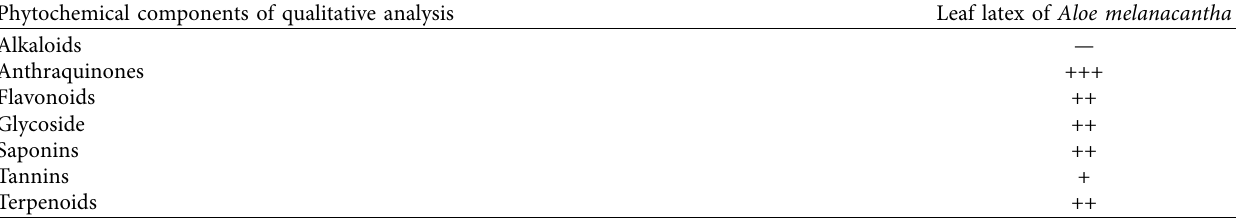
Table 1: Preliminary phytochemical screening of the leaf latex of Aloe melanacantha .